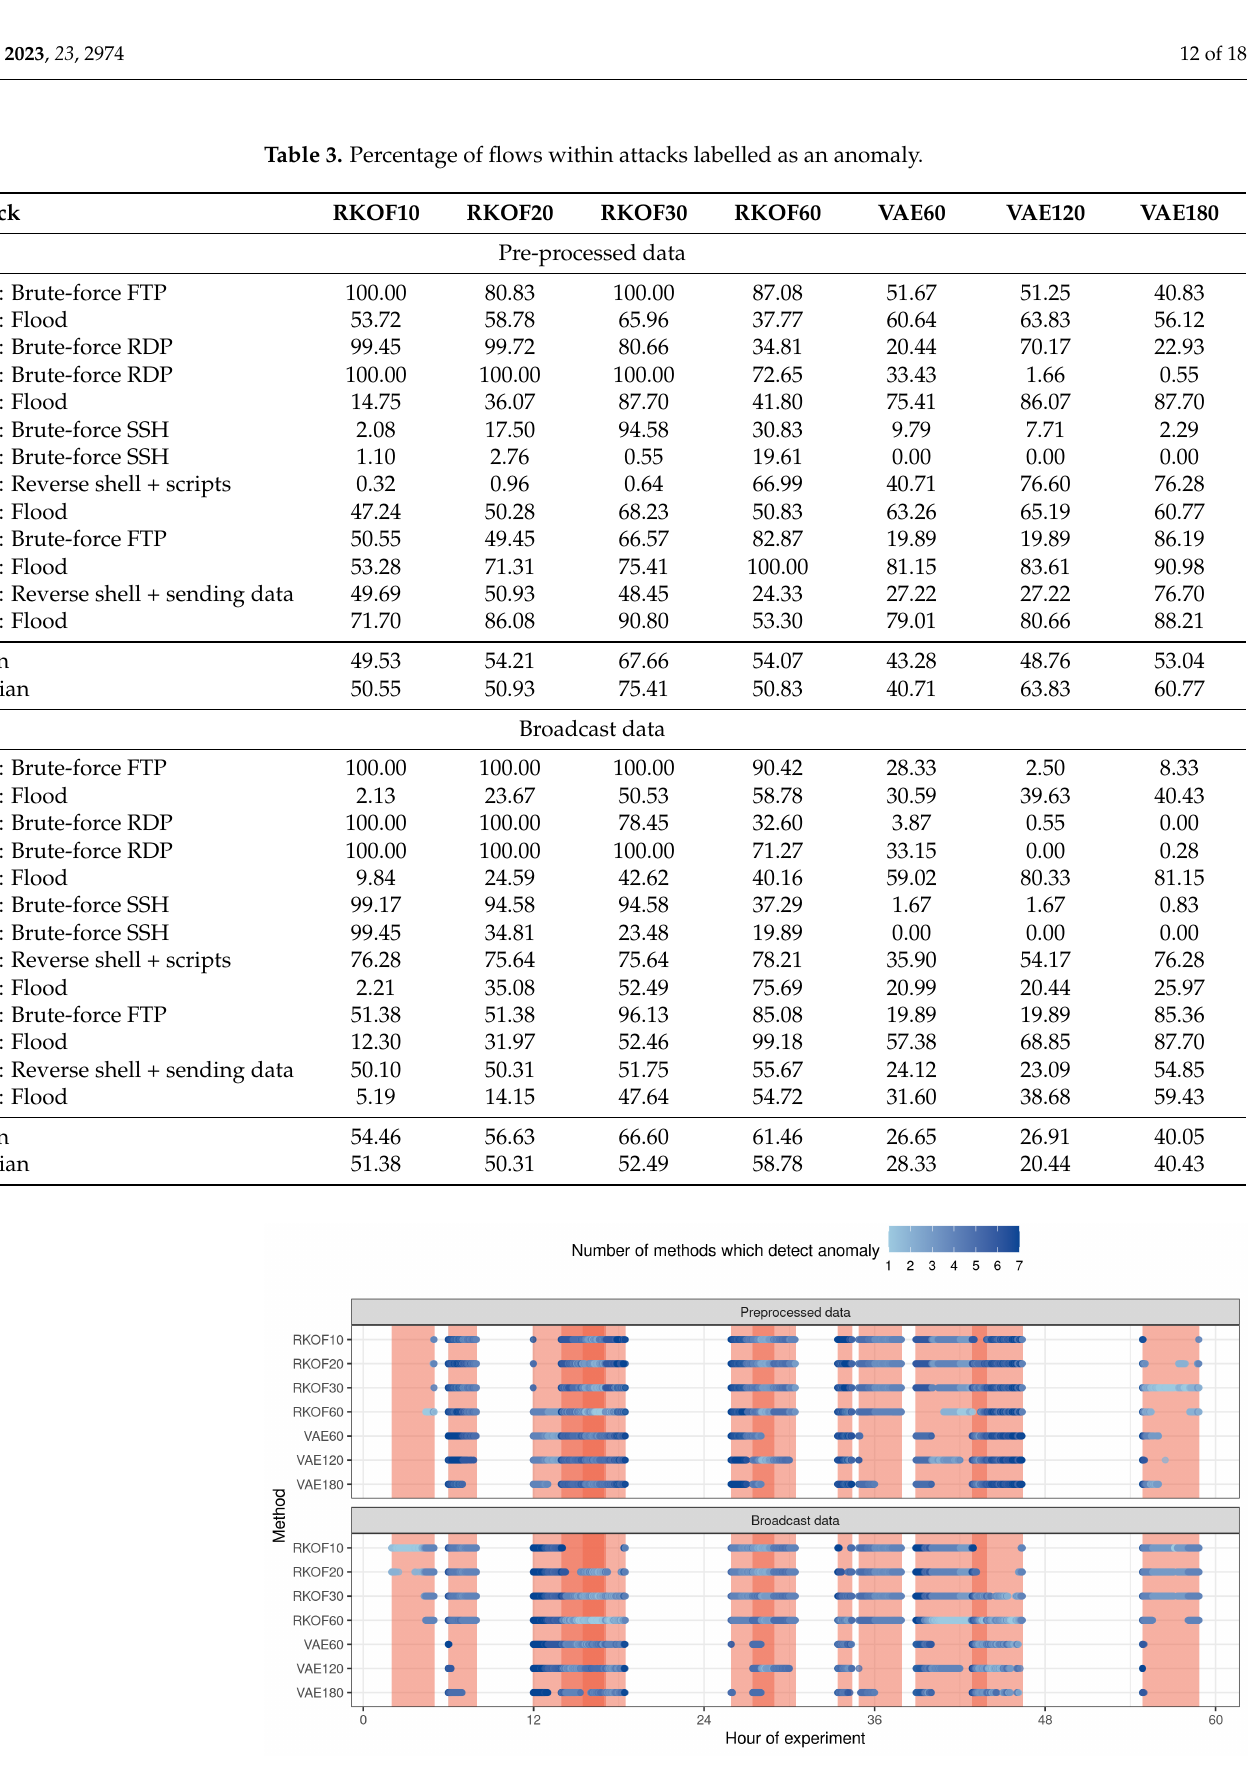
Figure 4. Anomalies in the traffic (vertical bars) and correctly recognized anomalies (points) for each model separately; the more intense the colour of the point, the more models recognized the